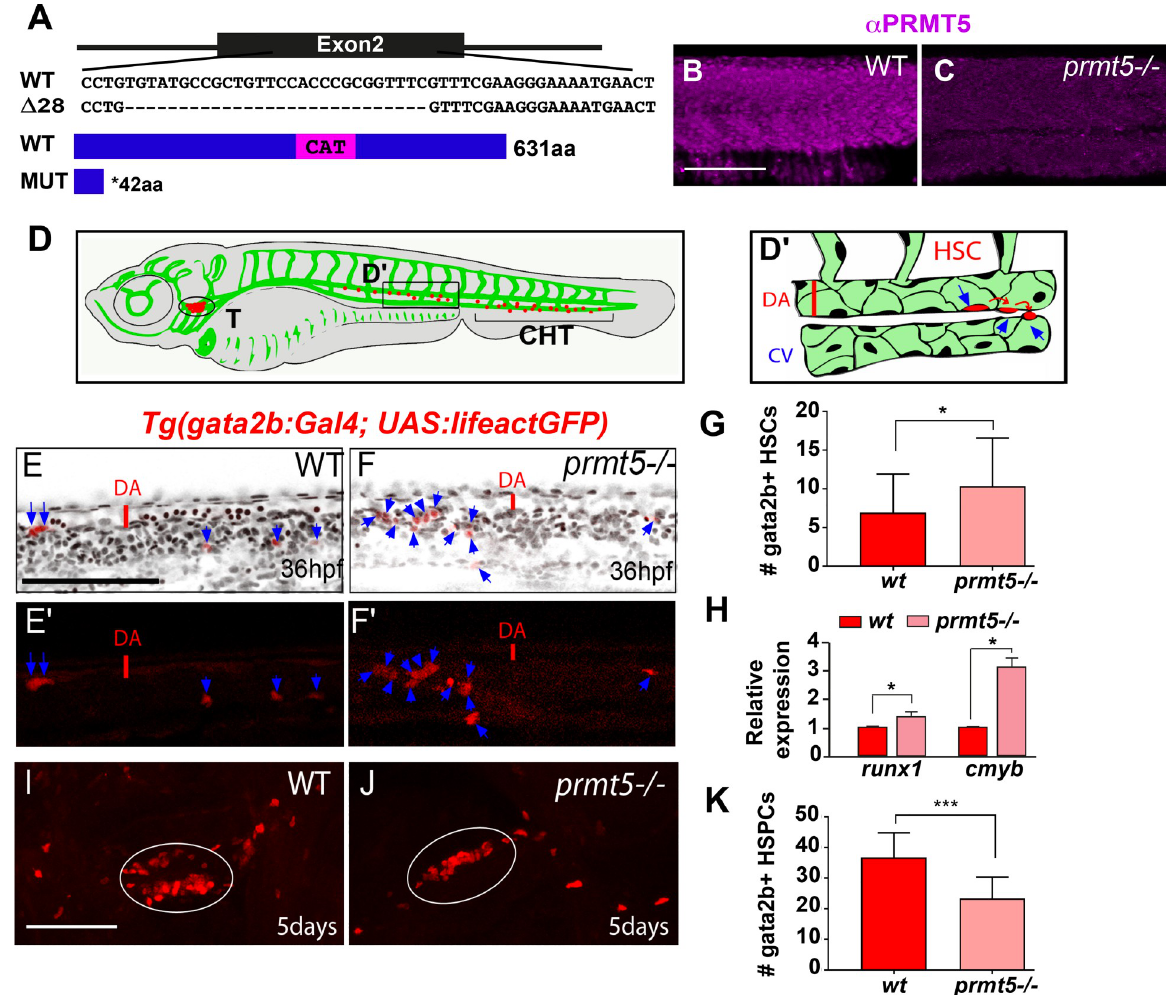
Fig 1. Loss of prmt5 affect HSCs and HSPCs production. (A) Schematic representation of the sequence targeted by CRISPR/Cas9 leading to a 28 nucleotides deletion, and of wild type and truncated Prmt5 proteins. The catalytic domain “CAT” appears in magenta. (B, C) Confocal sections of immunostaining with anti-Prmt5 antibody of wild type and prmt5 mutant embryos at 24 hpf. Scale bar 100 μ m. (D) Schematic representation of vascular (green) and hematopoietic (red) systems in a zebrafish larva. Circle and bracket indicate the Thymus (T) and the Caudal Hematopoietic Tissue (CHT), respectively. (D’) Close-up of the trunk vasculature where HSCs emerge from the ventral wall of the dorsal aorta (DA), bud and migrate. Red line represents the diameter of the dorsal aorta. Cardinal Vein (CV). (E-F’) Confocal projections of transgenic Tg ( gata2b : Gal4; UAS : lifeactGFP ) embryos at 36 hpf showing gata2b+ cells in red and TO-PRO-3 (cell nuclei) in black. Blue arrows indicate HSCs labelled in red in wild type (E, E’) and in prmt5 mutant (F, F’) embryos. Scale bar 100 μ m. (G) Average number of HSCs enumerated per confocal stack in wild type and in prmt5 mutant embryos at 36 hpf. Data are from 3 independent experiments with at least 6 individuals per experiment and a Mann-Whitney test was performed. (H) Relative mRNA expressions determined by RT-qPCR in the trunk of 36 hpf wild type and prmt5 mutant embryos, from 3 independent experiments with at least 6 animals per condition. T-test was performed. (I, J) Confocal projections of wild type (I) and prmt5 mutant (J) thymus from transgenic Tg( gata2b : Gal4; UAS : lifeactGFP ) embryos at 5 days. Thymus are delimited by a white circle. Scale bar 100 μ m. (K) Average number of HSPCs enumerated per confocal stack in wild type and prmt5 mutant embryos at 5 days from 3 independent experiments with at least 5 individuals per analysis. T-test was performed. � P < 0.05, �� P < 0.01, ��� P < 0.001.